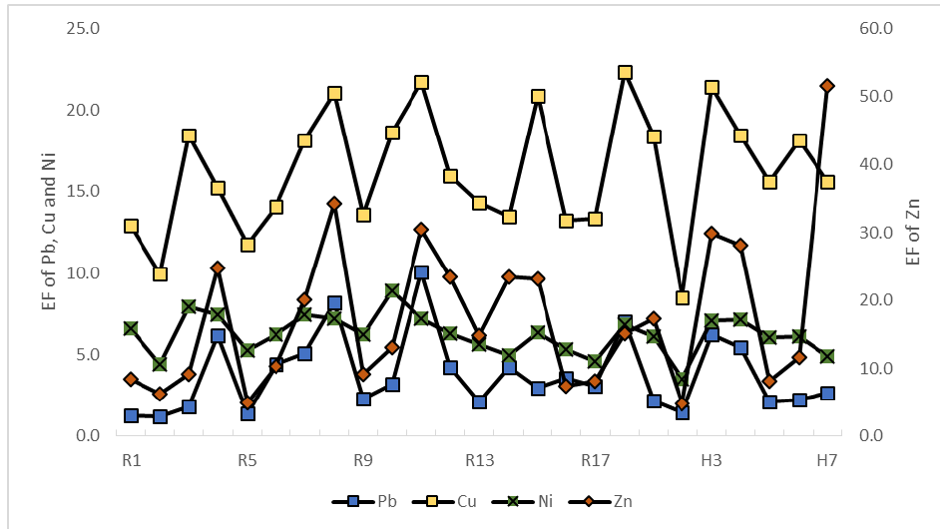
Figure 4: Variation of EFs of different heavy metals in the both road and household dust samples